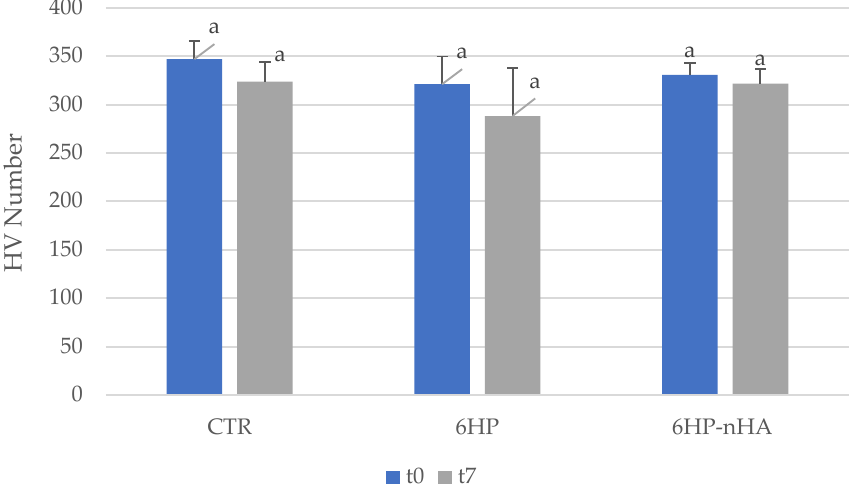
Figure 1. Microhardness values, expressed as HV number (Kg/mm 2 ), of Control Group (CTR), 6% hydrogen peroxide (6HP) and 6% hydrogen peroxide and nano-hydroxyapatite (6HP- nHA) at the baseline (t0) and after 7 days after bleaching treatment (t7). Different superscript letters indicate statistical significance. HV—Hardness value. Two-way repeated measures ANOVA—Tukey’s multiple comparison test, p < 0.05.